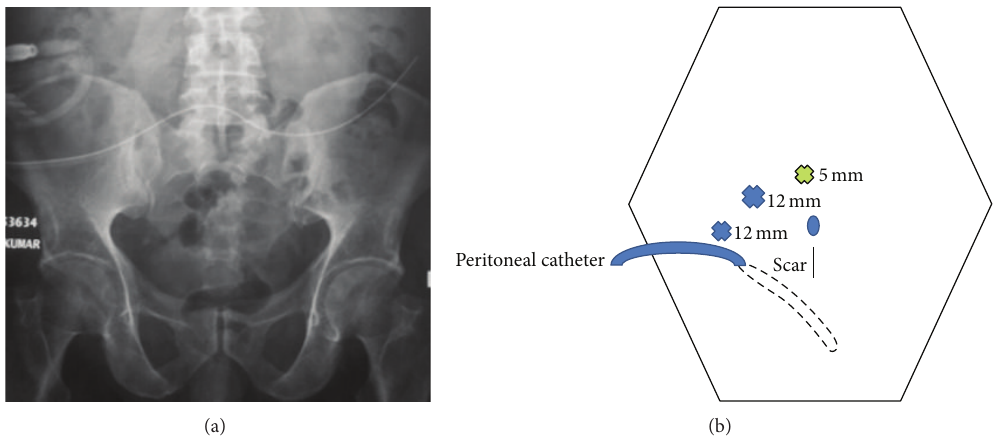
Figure 1: X-ray abdomen showing migrated CAPD catheter lying outside the pelvis (a). Illustration of laparoscopic port placement (b). The middle 12mm blue cross is the camera port while the corners 12mm and 5 mm are the working ports.